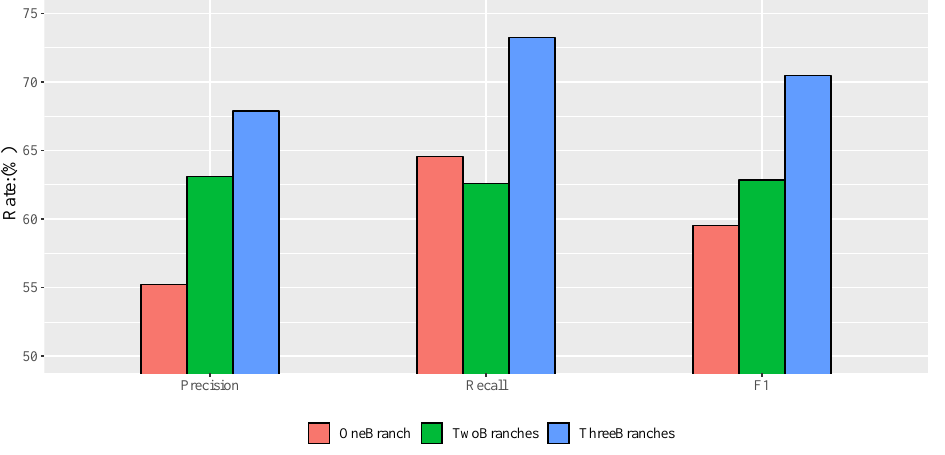
Figure 19. Comparison of detection results for different numbers of branch in Test Area